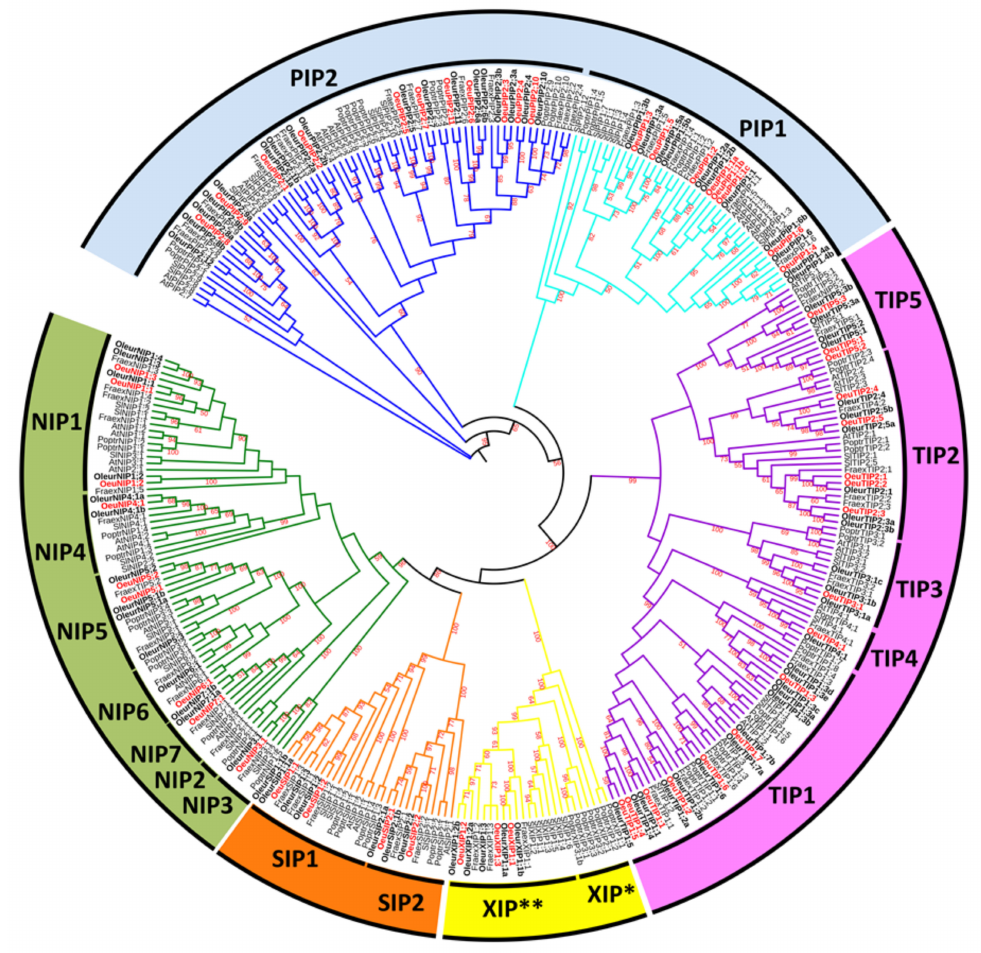
Figure 1. Phylogenetic analysis of protein sequences of the 52 Oeu AQPs and the 79 OleurAQPs with Fraxinus excelsior , Arabidopsis thaliana and Populus trichocarpa hortologs. Deduced amino acid sequences were aligned using ClustalW, and the phylogenetic tree was constructed using the maximum parsimony method. Maximum parsimony analysis was conducted using the subtree-pruning-regrafting algorithm. The number next to the branches represents bootstrap values ≥ 50% based on 5000 resampling. The distance scale denotes the number of amino acid substitutions per site. The AQP sequences from O. europaea var. sylvestris , O. europaea cv. Picual, F. excelsior , A. thaliana and P. trichocarpa are preceded by the prefixes Oeu, Oleur, Fraex, At and Poptr, respectively. Oeu AQPs are mentioned in red, and Oleur AQP in bold. The name of each subfamily and subgroup is indicated next to the corresponding group. XIP* and XIP** correspond to XIP sequences from Rosids and Asterids, respectively. Oeu AQP accession numbers and sequences are listed in and Figures 3 and S1 . Oleur AQP and Fraex AQP accession numbers and sequences are listed in Figures S2 and S3, respectively. This Figure 1 is also presented in Supplemental Figure S4 with high definition for ease of